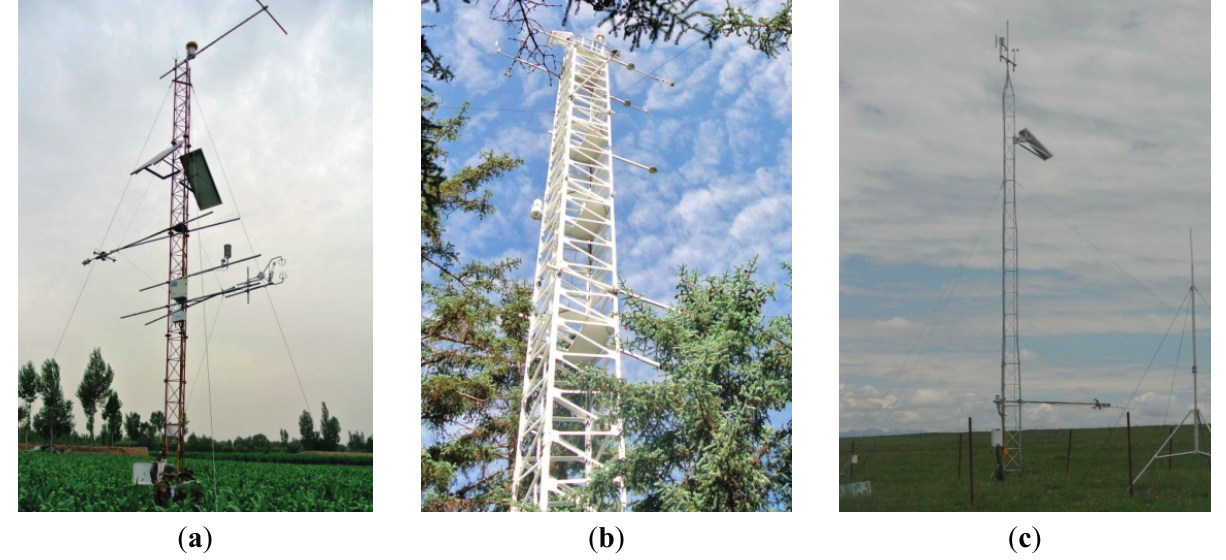
Figure 4. PAR observation stations in the Heihe River Basin. ( a ) The underlying surface is crop; ( b ) the underlying surface is forest; ( c ) the underlying surface is